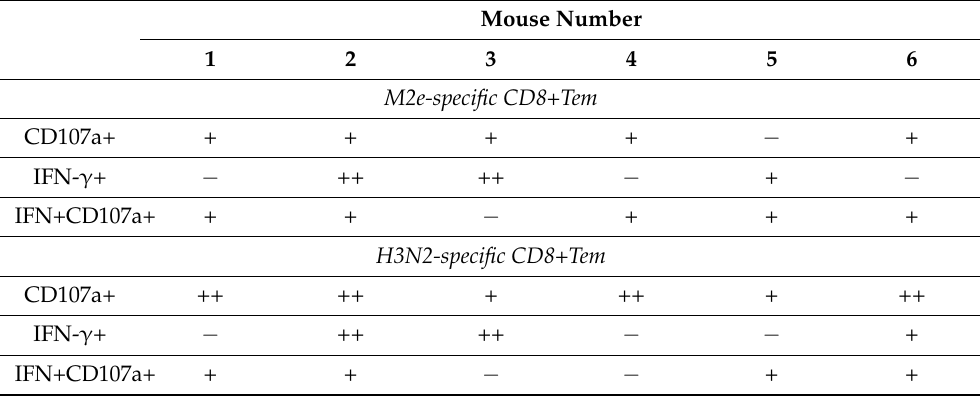
Table 1. Functional characteristic of antigen-specific CD8+Tem lungs cells in C57Bl/6 mice.